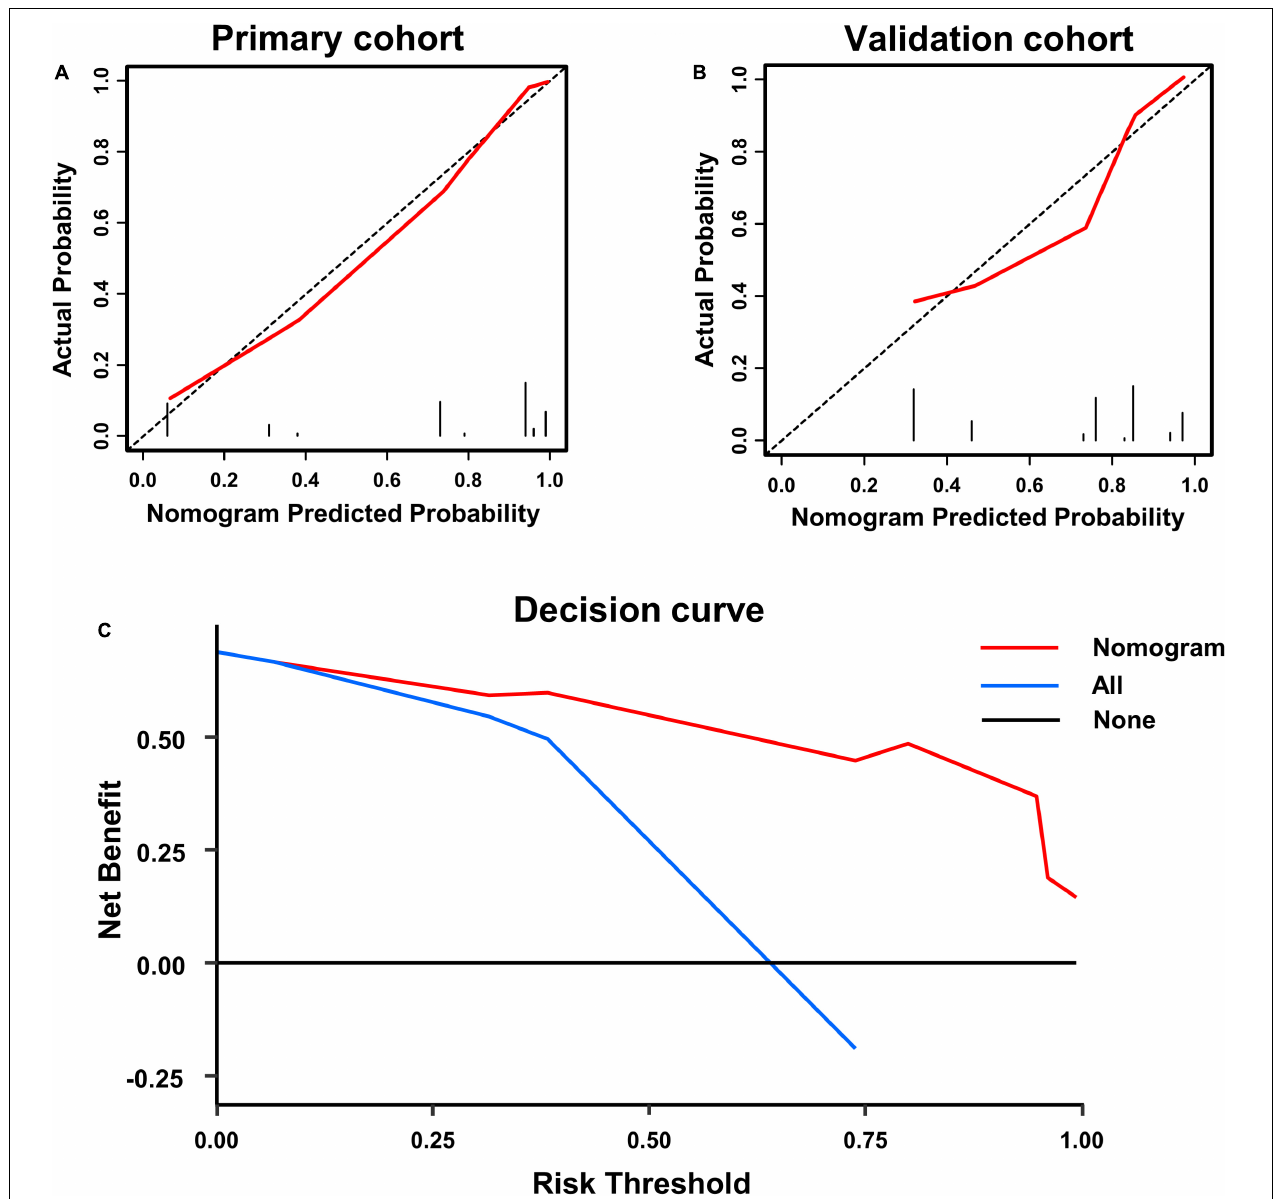
FIGURE 3 | Calibration curve of poor prognosis prediction model in primary cohort (A) and validation cohort (B) ; and (C) presents the decision curve for all